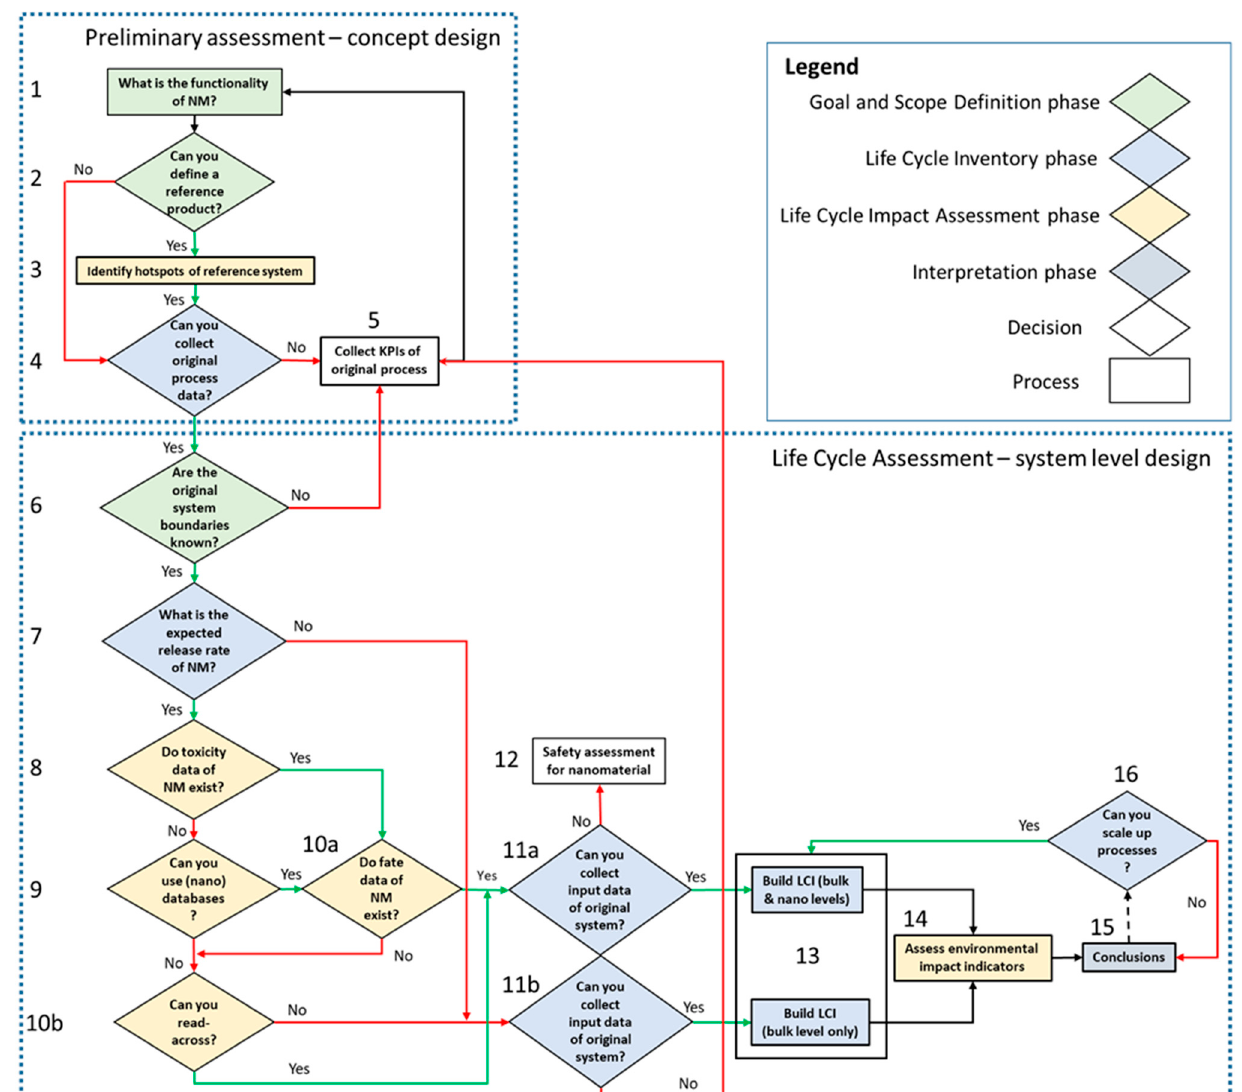
Figure 1. Flow chart of proposed LCA ‐ based framework.